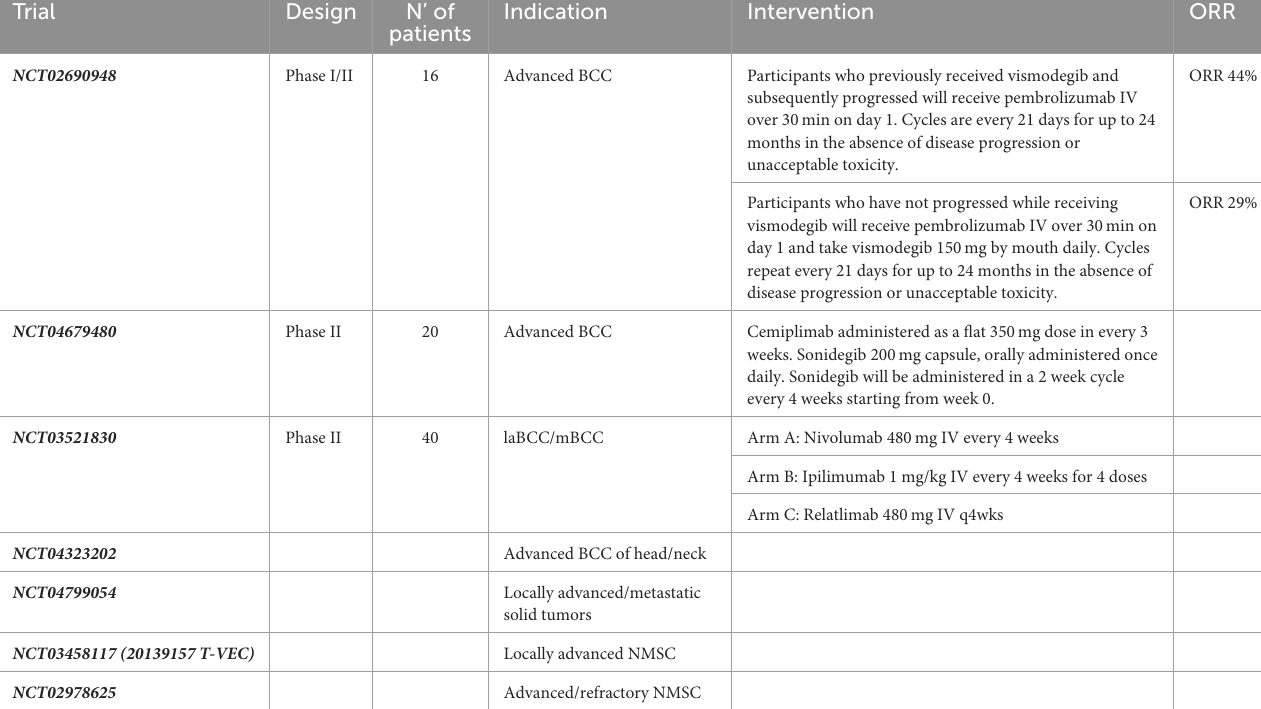
TABLE 2 Ongoing trials in BCC. Trial